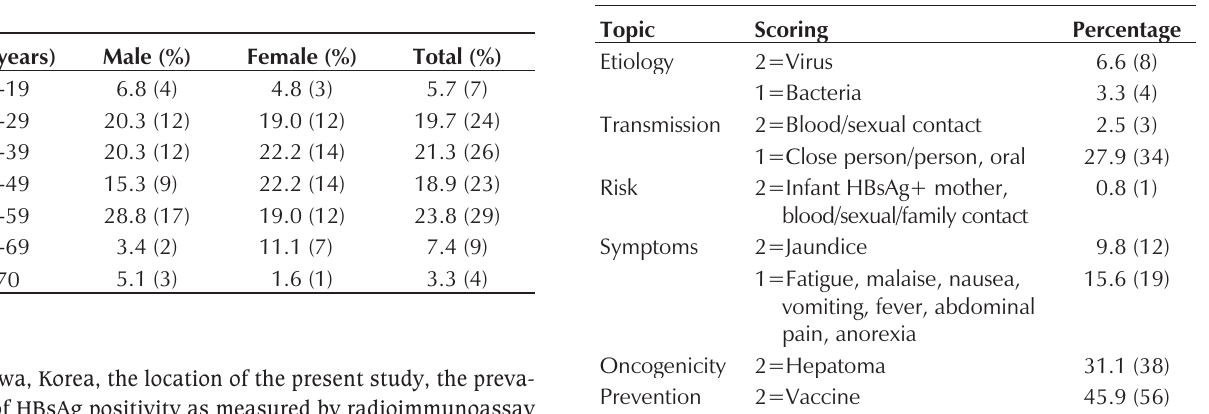
Distribution of Kanghwa, Korea survey population by sex